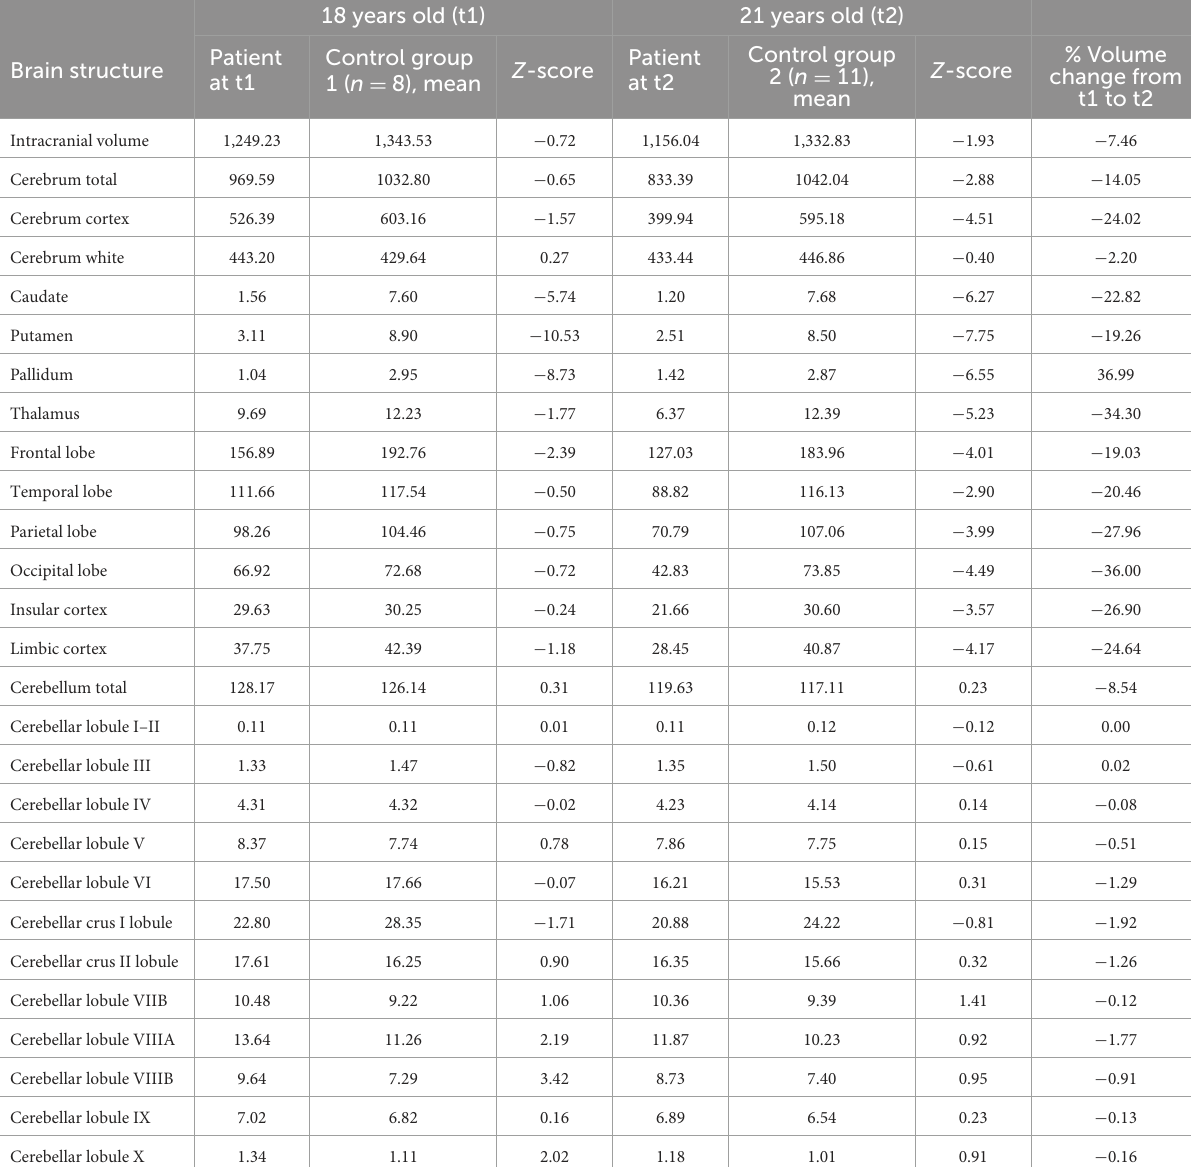
TABLE 1 Volumes of brain structures in the patient with juvenile Huntington’s disease and controls.